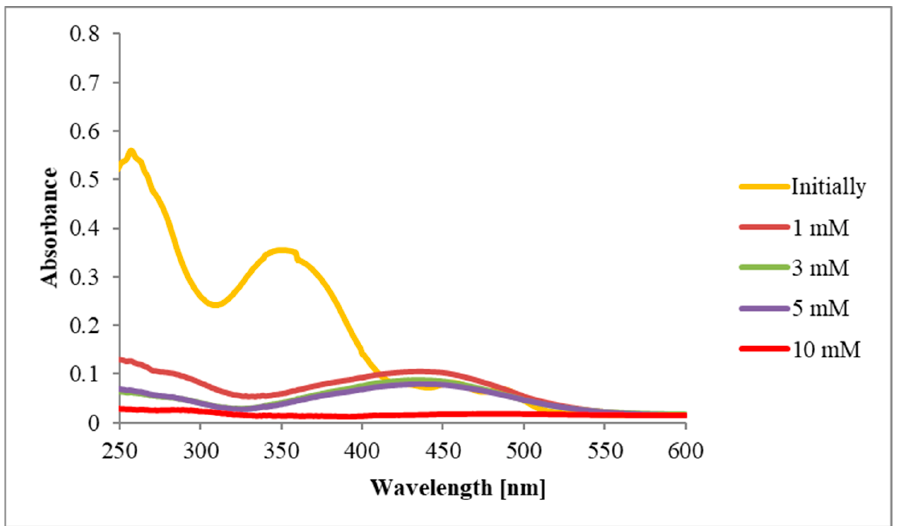
Figure 2. The influence of different AgNO 3 concentrations (1 mM, 3 mM, 5 mM, and 10 mM) on AgNPs-EtOH formation.